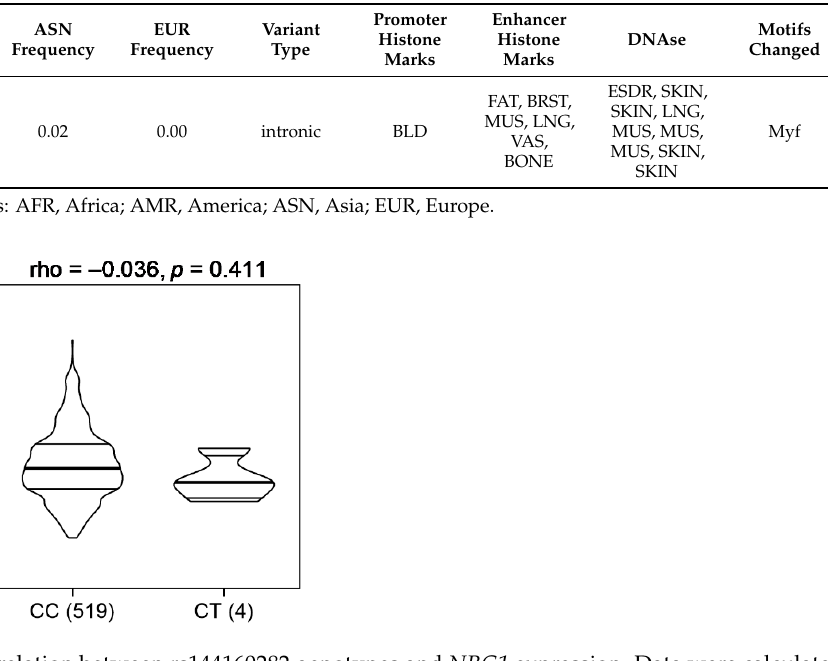
Table 3. Functional annotation of NRG1 rs144160282.